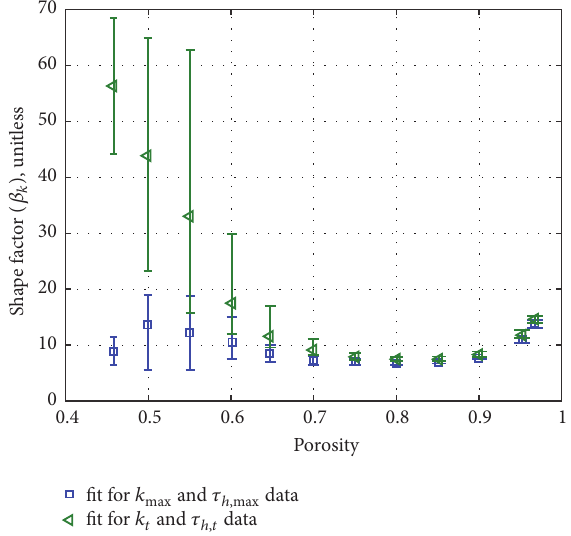
Figure 20: Shape factor, 𝛽 𝑘 , used to fit simulated permeability and hydraulic tortuosity data to Kozeny-Carman equation for geometries comprised of randomly distributed squares. 𝛽 𝑘 appears to be constant between 0.7 < 𝜙 < 0.9